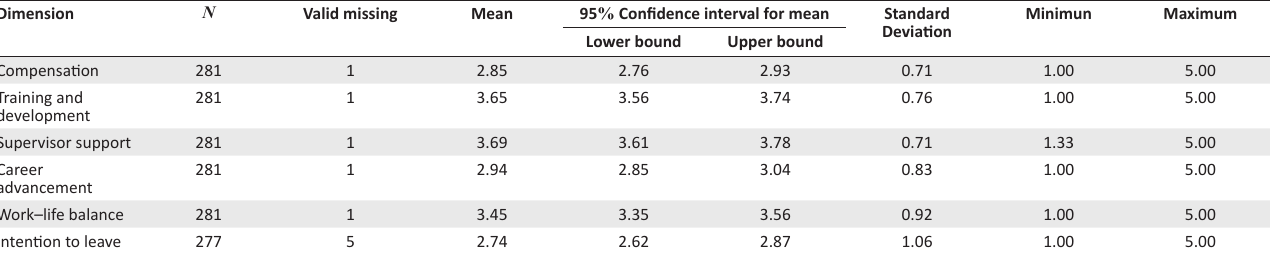
TABLE 1: Descriptive statistics for retention factors and intention to leave dimensions. Dimension N Valid missing Mean 95 % Confidence interval for